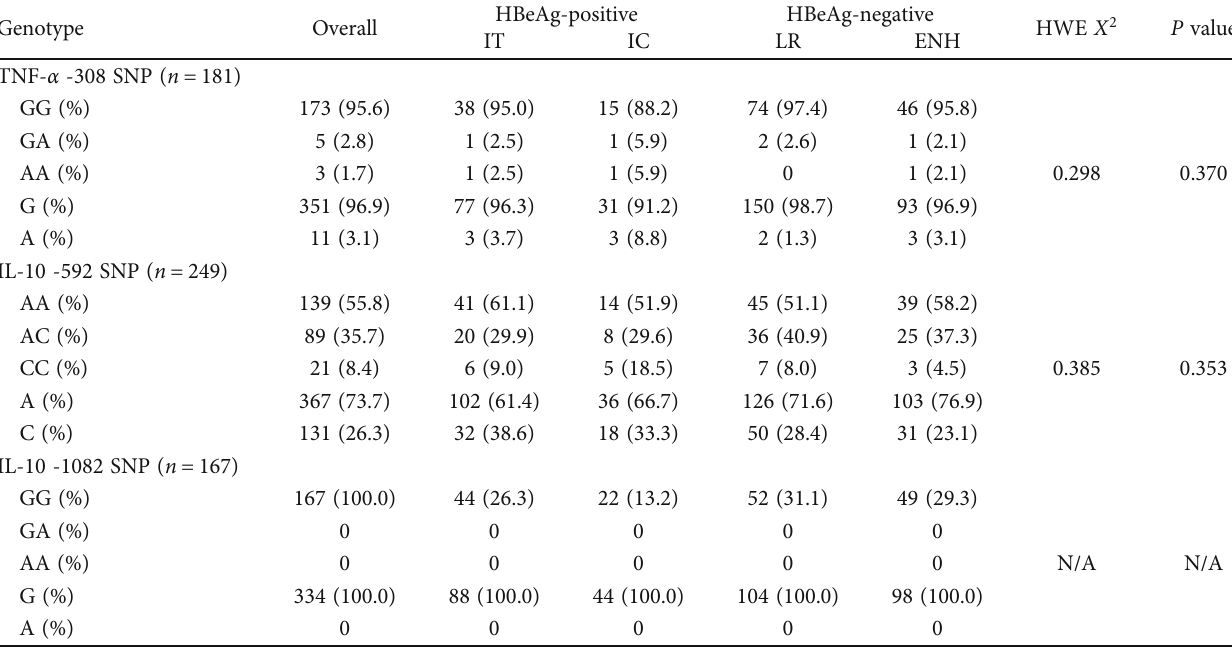
Table 2: Distribution of TNF- α -308, IL-10 -592, and IL-10 -1082 genotypes and alleles in di ff erent phases of natural history of chronic hepatitis B